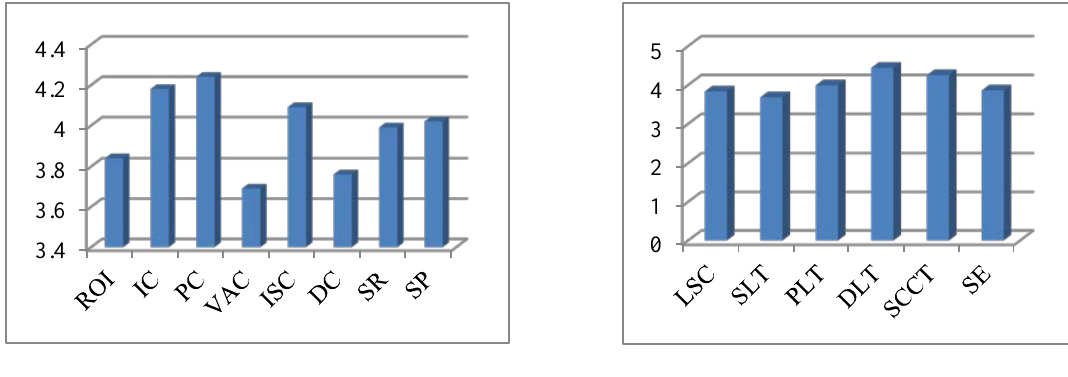
Fig. 8. Financial practices Fig. 9. Supply chain